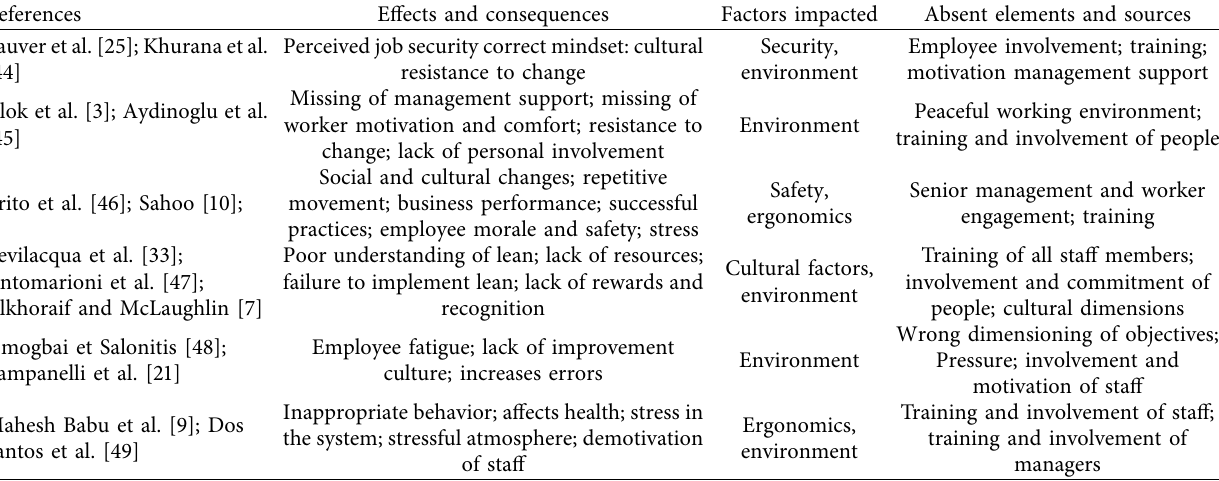
Table 3: Review of the most important effects and consequences on ESE